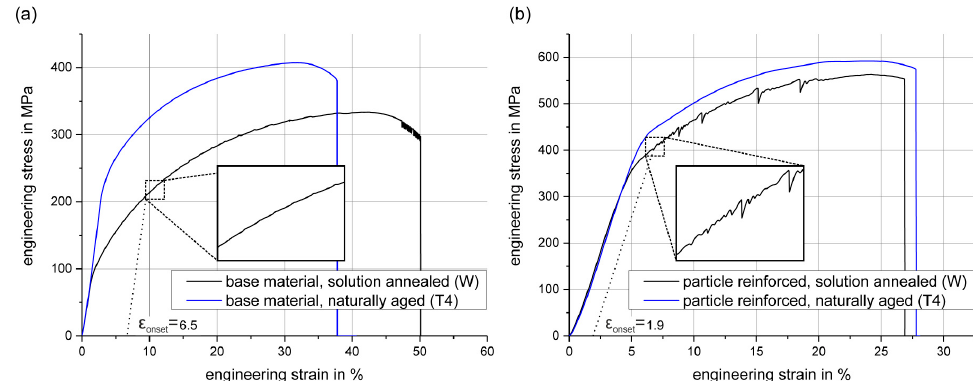
Figure 3. Stress-strain curves of ( a ) the AA2017 base material in the solution annealed condition W and in the naturally aged condition T4, and ( b ) of the particle reinforced AA2017 material in solution annealed condition W and in naturally aged condition T4. Only the W-conditions exhibit serrated flow. In the inset with a higher magnification, type A PLC serrations can be observed.